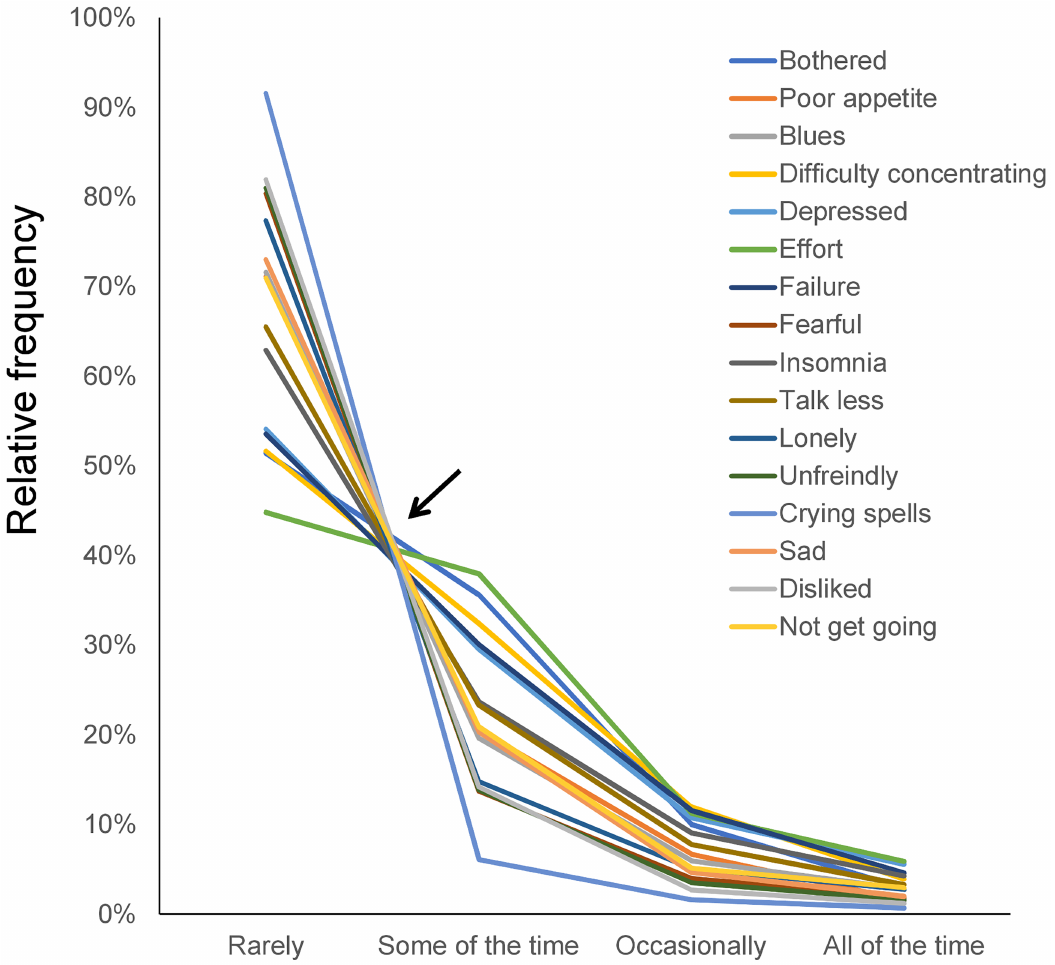
Fig 1. Item responses for the 16 depressive symptom items included in the Japanese survey. Responses to the 16 items exhibited a common mathematical pattern. The lines for the 16 items intersect at a single point (black arrow) between “rarely” and “some of the time,” while the lines between “some of the time” and “all of the time” decrease regularly. Reprinted from [9]. Image credit: PLoS ONE at